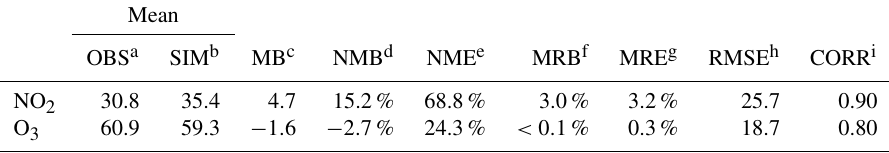
Table 4. The performance statistics for NO 2 and O 3 in modeling (unit: µgm − 3